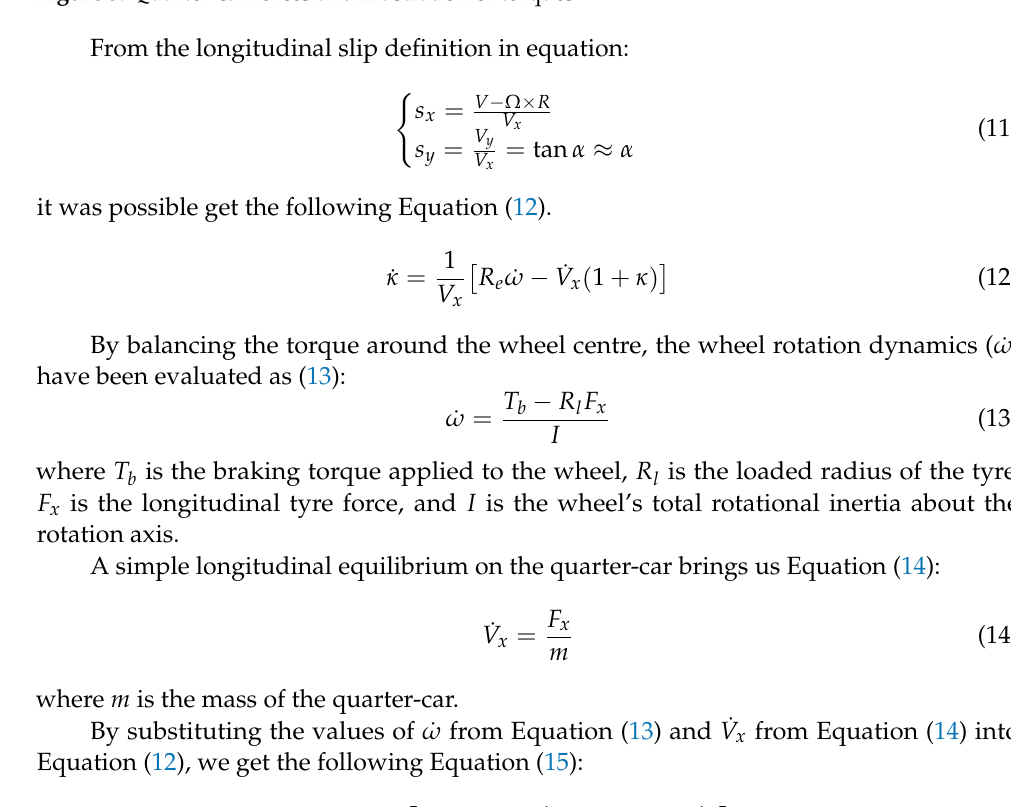
Figure 5. Quarter-car forces and illustration of